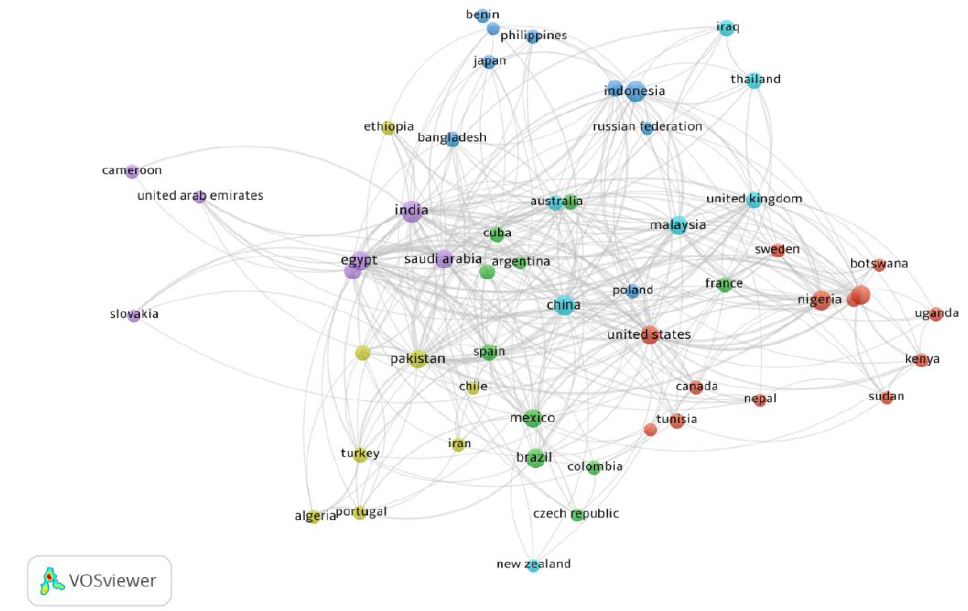
Figure 2. Network visualization of international collaborative research conducted for M. oleifera using VOS viewer (1.6.18).